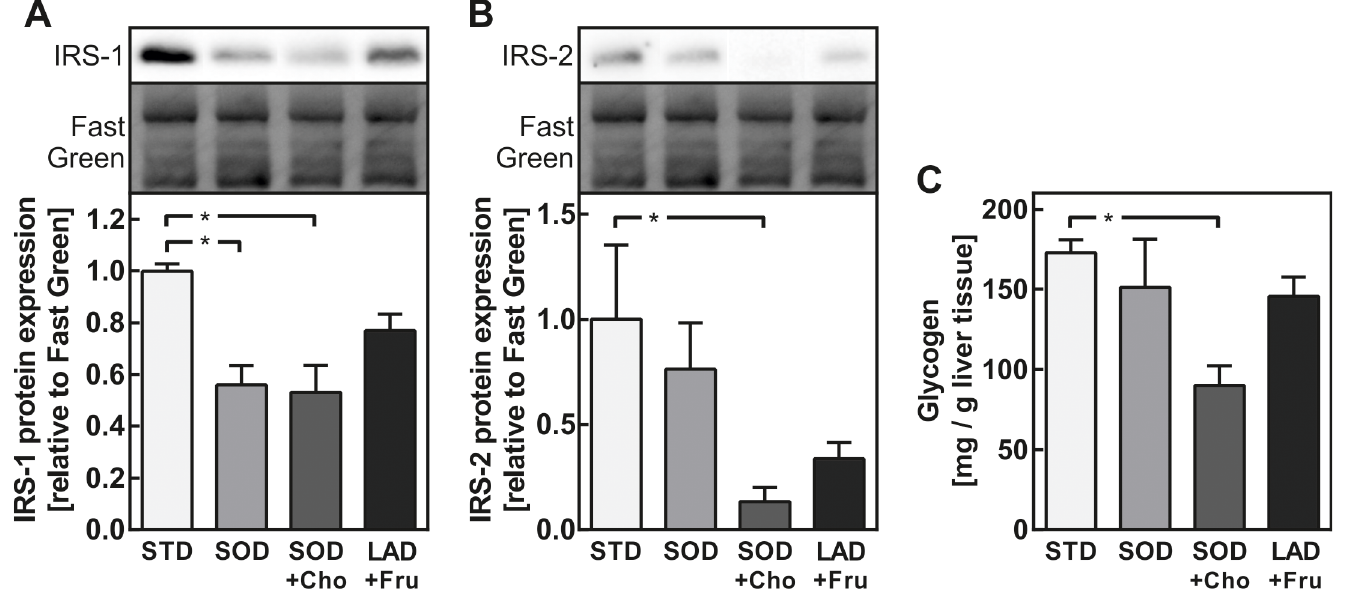
Figure 5. Dietary cholesterol in soybean oil diet impaired hepatic insulin signaling. Mice received diets as described in Figure 1. Protein levels of (A) insulin receptor substrate 1 (IRS-1) and (B) IRS-2 were determined in liver lysates by Western blot analysis with specific antibodies. Density units were normalized to Fast Green staining, which was verified on the same Western blot membrane as a loading control. (C) Hepatic glycogen content was enzymatically quantified in homogenates (see Materials and Methods section). Values rep- resent means ± standard error of the mean of 5 mice per group. Statistics: One-way analysis of variance with Dunnett’s post hoc test or, where appropriate, Tukey’s post hoc test for multiple comparisons, *p